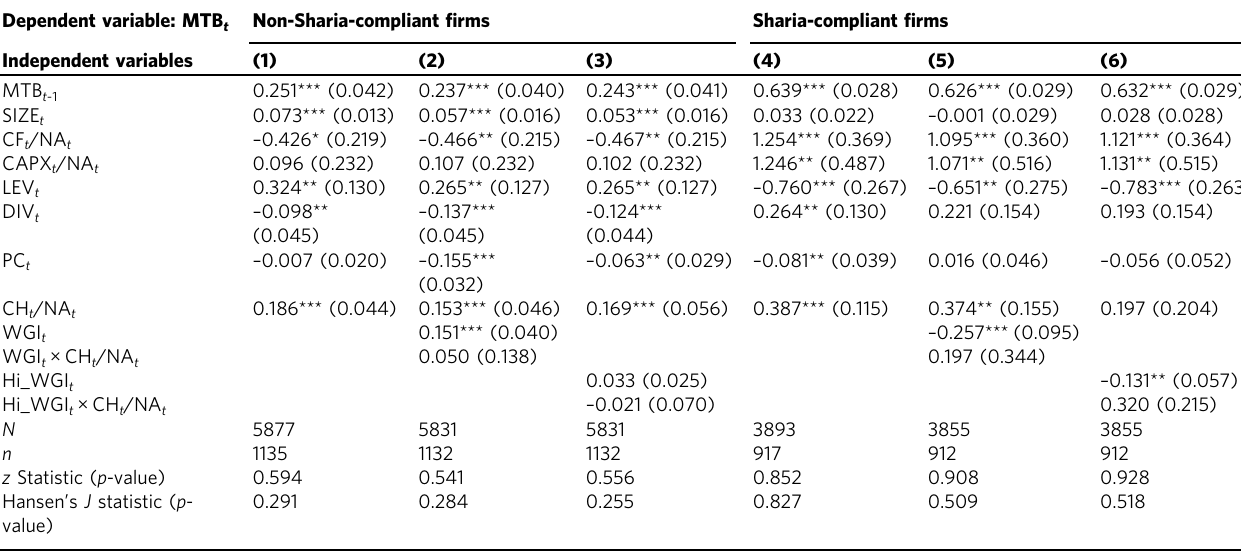
Table 6 Sharia compliance, national governance, and value of cash — sample partitions by Sharia compliance. Dependent variable: MTB t Non-Sharia-compliant fi